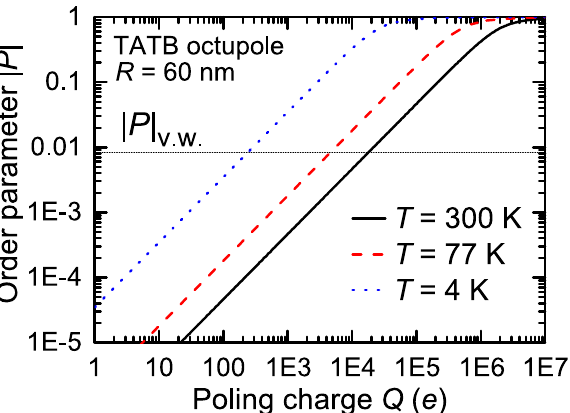
Figure 4. Order parameter | P | in the central part of a point charge poling cell in function of the poling charge Q for selected temperatures. The order parameter